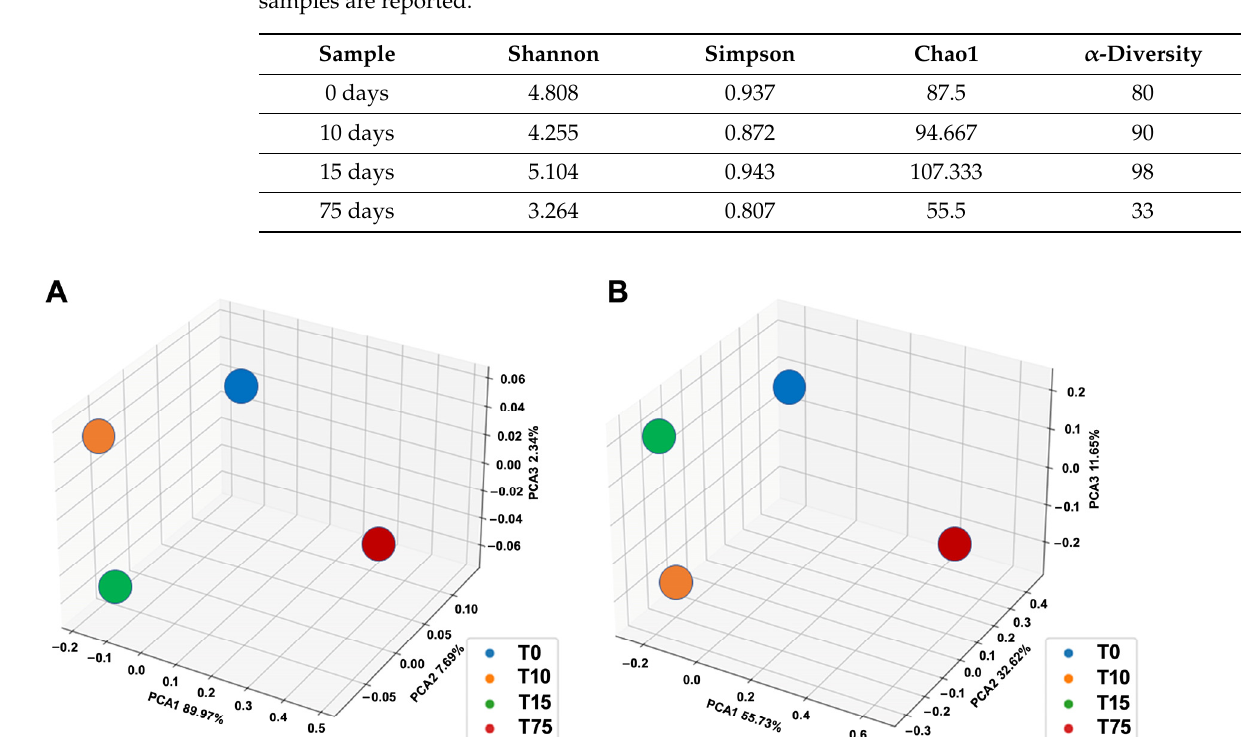
Table 3. Alpha-diversity metrics for the RRIA samples sequenced by 16S rRNA amplicon NGS. Alpha-diversity metrics (Shannon’s, Simpson’s, Chao1 and alpha-div) for the four selected sequenced samples are reported.